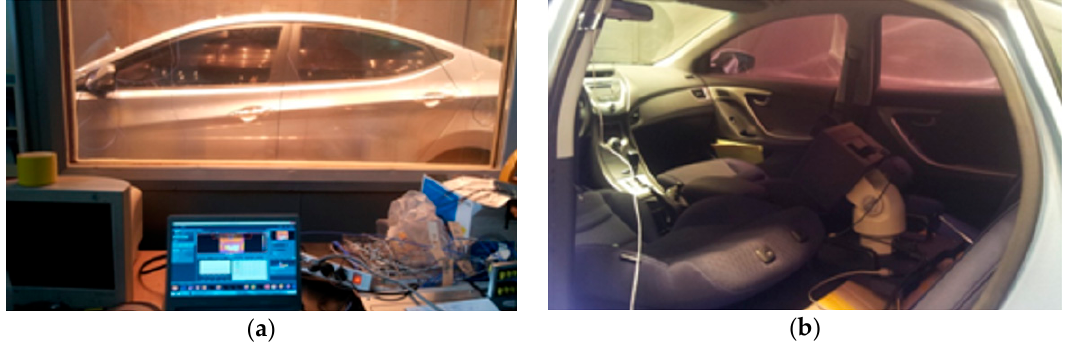
Figure 17. Actual vehicle evaluation environment: ( a ) Test environment; ( b ) Inside vehicle.